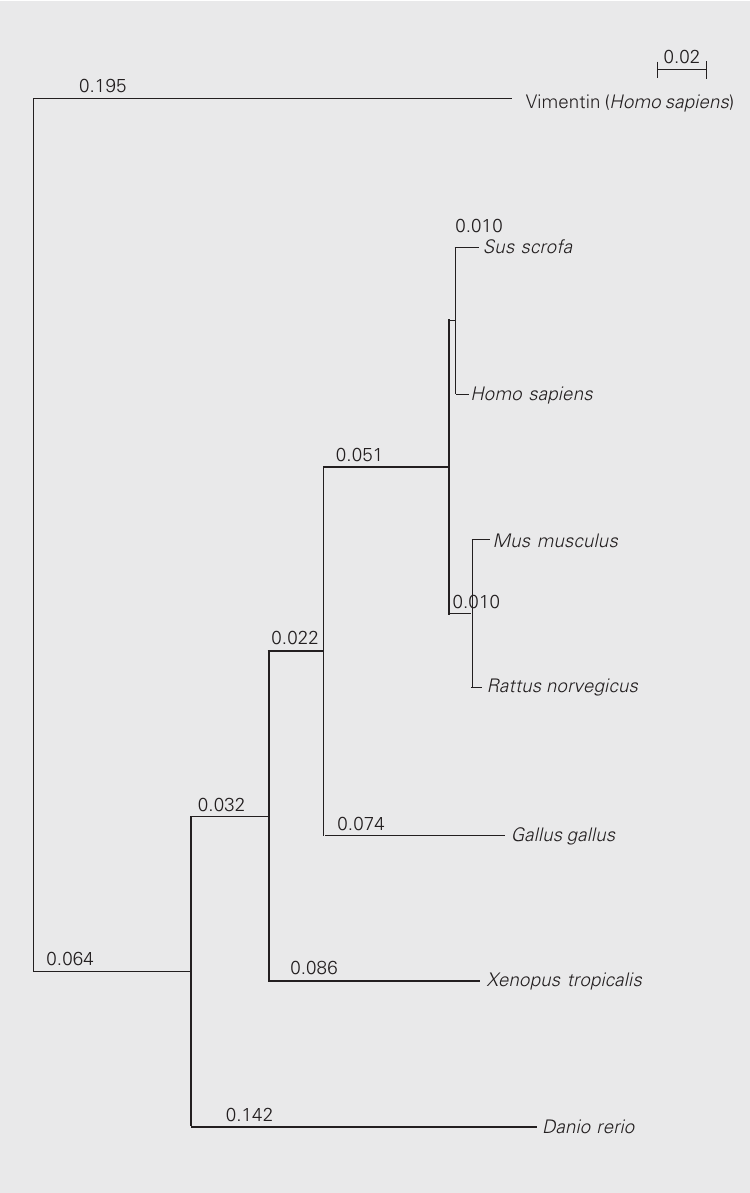
Figure 1. Phylogenetic relationships of desmin from several animals. Multiple sequence alignments were generated following the alignment of the human gene using the CLUSTALX software. The evolutionary tree was prepared with the NIPLOT software. This figure shows that desmin is quite conserved evolutionarily. The changes are very well related to phylogeny (more time of species divergence, more differences among the desmins). This constant rate of evolutionary change over time indicates that desmin should be on a high selective pressure and should have a high adaptive value. The following sequences were obtained from PubMed: 1-gi|6686280|Desmin[ Homo sapiens ], 2-gi| 118453|Desmin[ Gallus gallus ], 3-gi|48374063|Desmin[ Sus scrofa ], 4-gi|38197676| Desmin[ Rattus norvegicus ], 5-gi|33563250|Desmin[ Mus musculus ], 6 gi|38511808| Desmin[ Xenopus tropicalis ], 7-gi|18858539|Desmin[ Danio rerio ], 8-gi|4507895|Vimentin| [ Homo sapiens